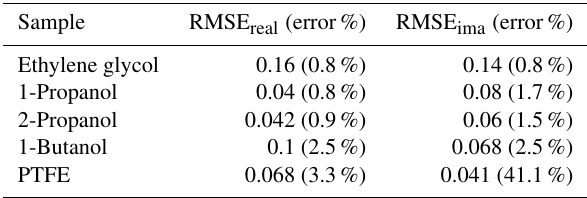
Table 2. Root mean square error (RMSE) between the measured L- band relative permittivity value (real and imaginary parts) and the accepted value in the scientific literature for the data presented in Figs. 5 and 6. The percentage of error is in